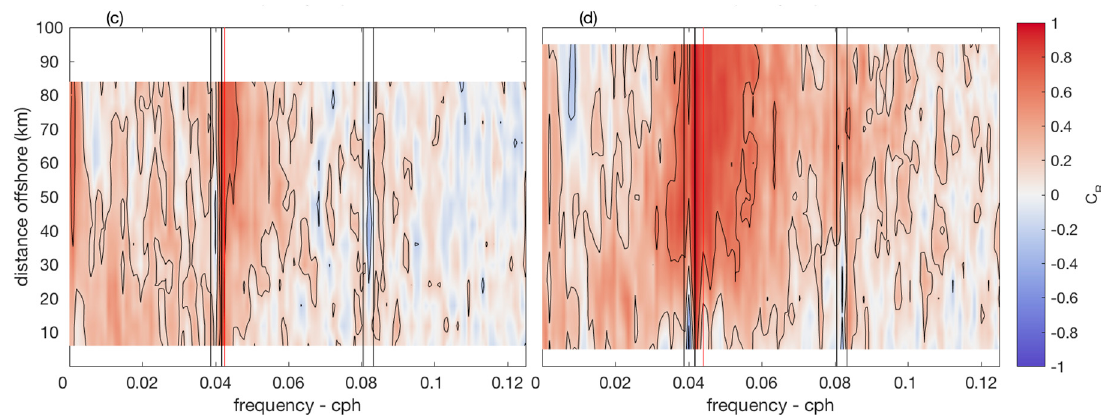
Figure 10. ( a ) Rotary power and rotary coefficient (C R ) spectra of hourly surface currents along two zonal (offshore) transects at 30°48 ′ S ( a , c ); and, 32° S ( b , d ). Vertical lines mark the semidiurnal, diurnal and inertial frequency bands at the two latitudes. Units are m 2 s − 2 cph − 1 and cycles per hour (cph) for rotary spectra and frequency axis; C R is dimensionless.